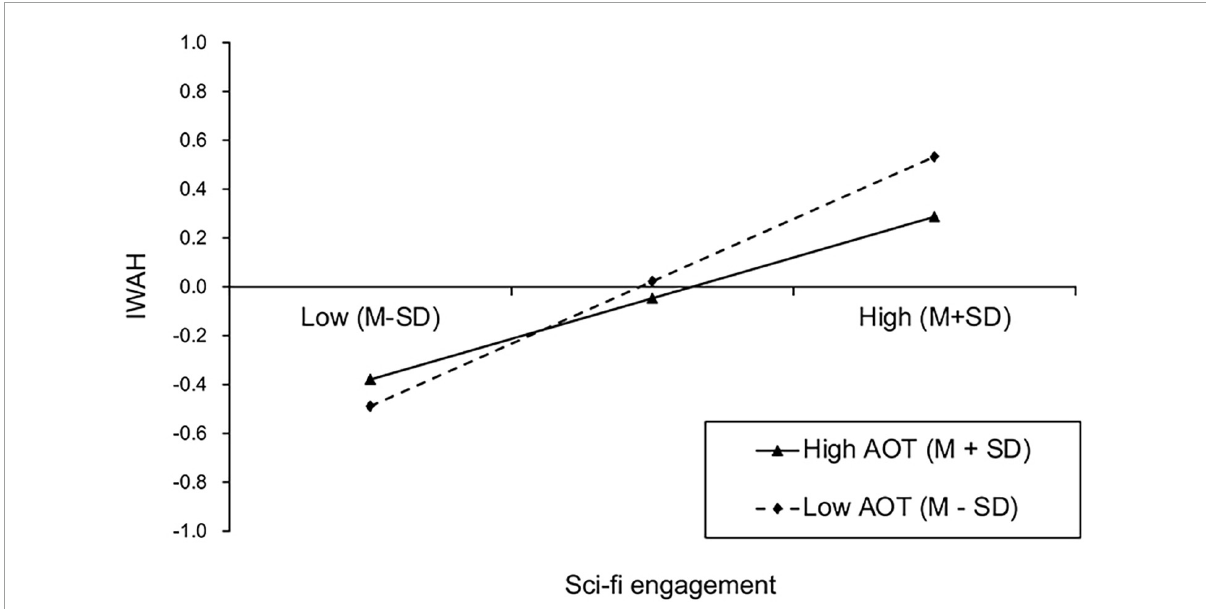
FIGURE3 Interaction effect of sci-fi engagement and AOT on IWAH. IWAH, Identification with all humanity; AOT, Actively open-minded thinking; M, Mean; SD, Standard deviation.